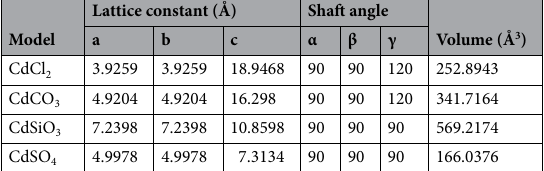
Table 1. Cell parameters of CdCl 2 , CdCO 3 , CdSiO 3 , and CdSO 4 .